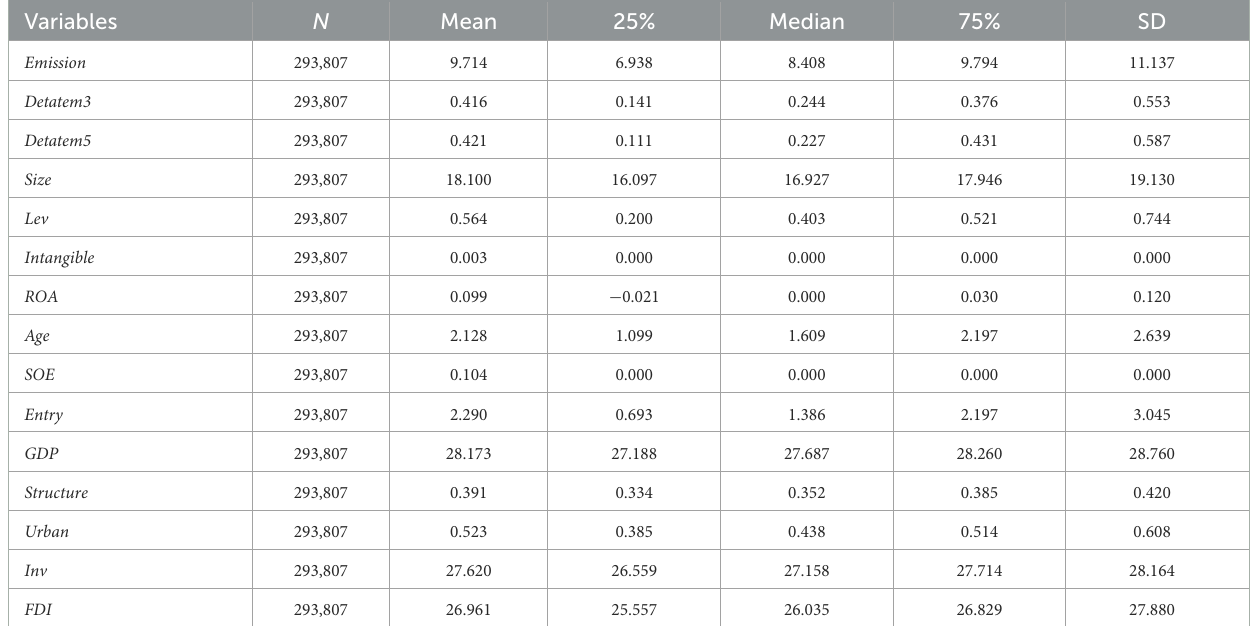
TABLE 2 Summary